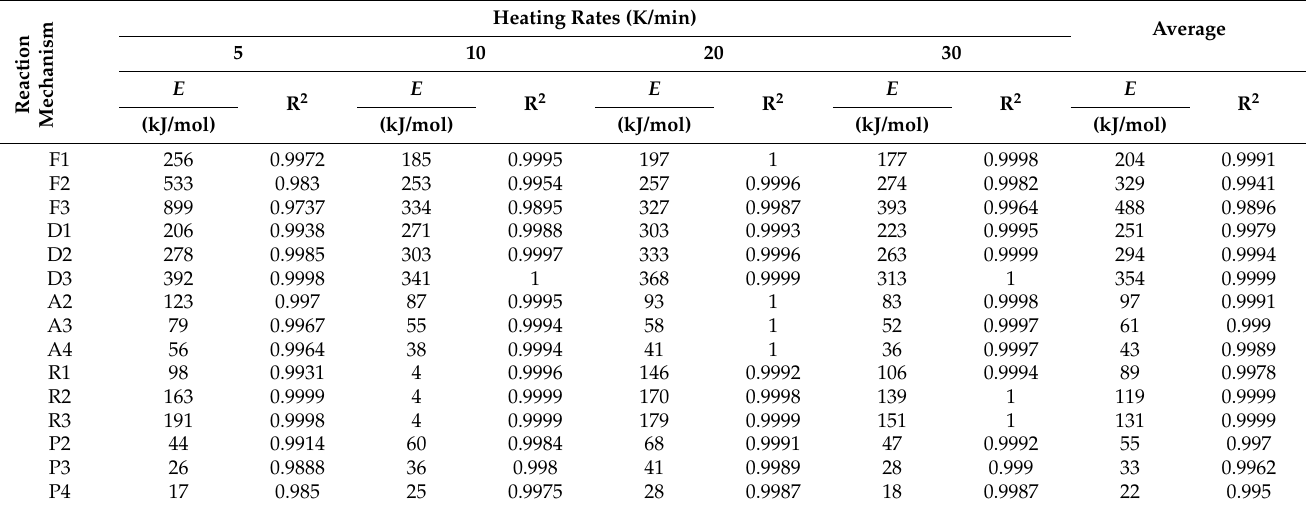
Table 10. Activation energy values obtained by the Coats–Redfern model.